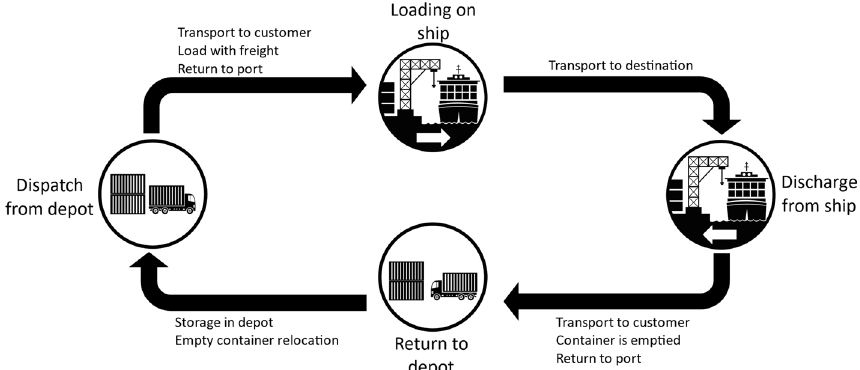
Fig. 1 Events during the transport process of containers. Source : Own figure